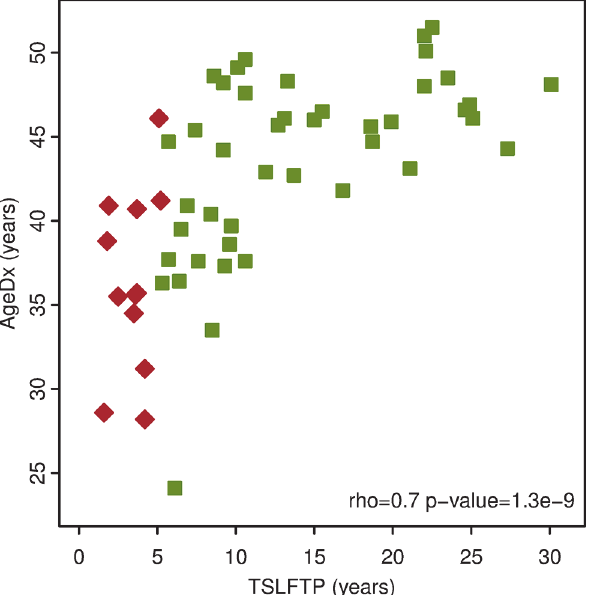
Fig 1. Ella sample case series. The graph illustrates distribution of the time since the last full-term pregnancy and the age at diagnosis of the tumor sample case series utilized in the study. The x-axis is the time since last full-term pregnancy (TSLFTP) in years. The y-axis is the age at diagnosis (AgeDx) in years. Red diamonds represent Ella FFPE samples (cid:1) 5.2 years postpartum. Green squares represent Ella FFPE samples (cid:3) 5.3 years